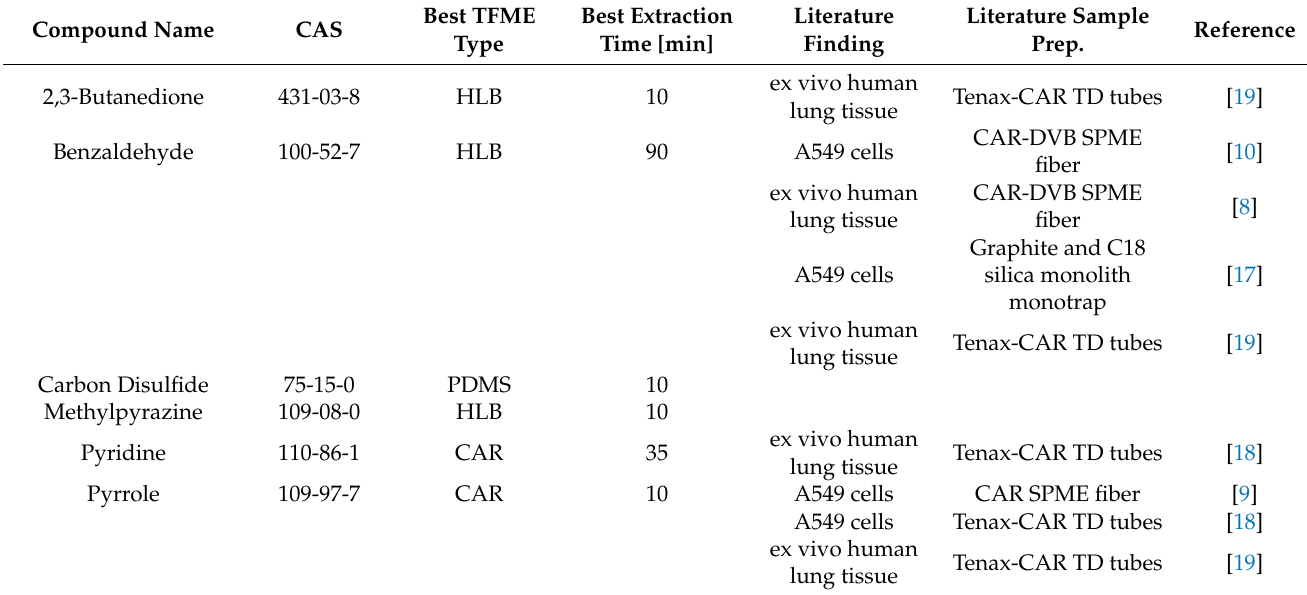
Table 2. Compounds identified as statistically important for A549 conditioned vs. control medium with respective relation to literature